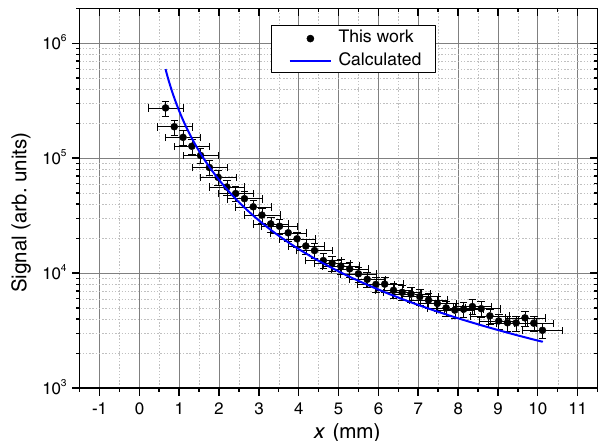
FIG. 8. Fluorescence signal drop along the central jet line from the PLIF measurements (black symbols). P 0 ¼ 360 mbar, P ¼ 1 . 5 mbar. The expected drop of the density following a bg 1 =R 2 trend is shown with a blue curve